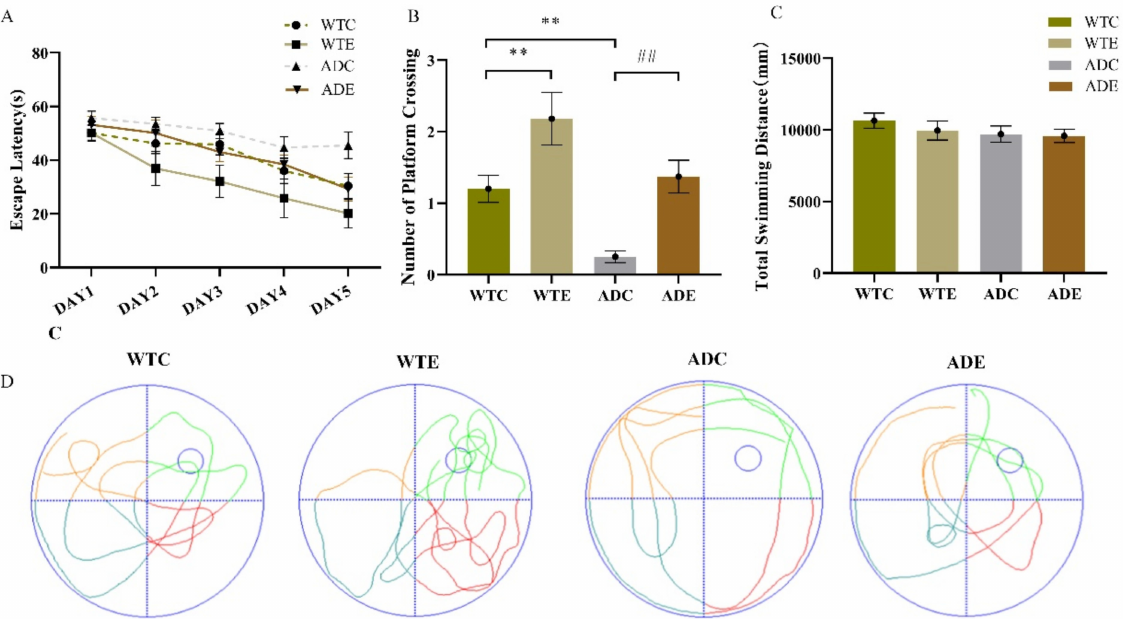
Figure 1. Effect of treadmill exercise on spatial learning and memory in mice. ( A ) Escape latency in the place navigation test. ( B ) Number of platform crossings in the spatial probe test. ( C ) Total swimming distance in the spatial probe test. ( D ) Swimming paths in the spatial probe test. n = 6 per group. ** p < 0.01 compared with WTC. ## p < 0.01 compared with